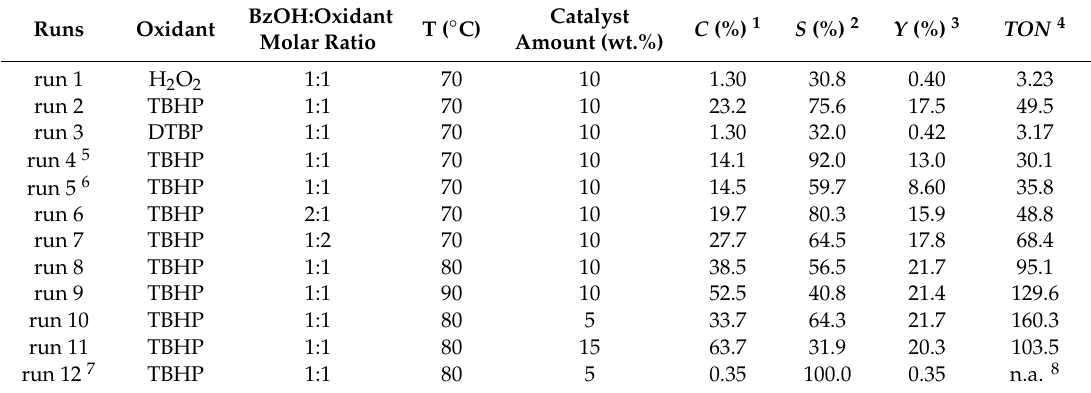
Table 6. Catalytic performance optimization of Ce-MCM-NO 3 for benzyl alcohol